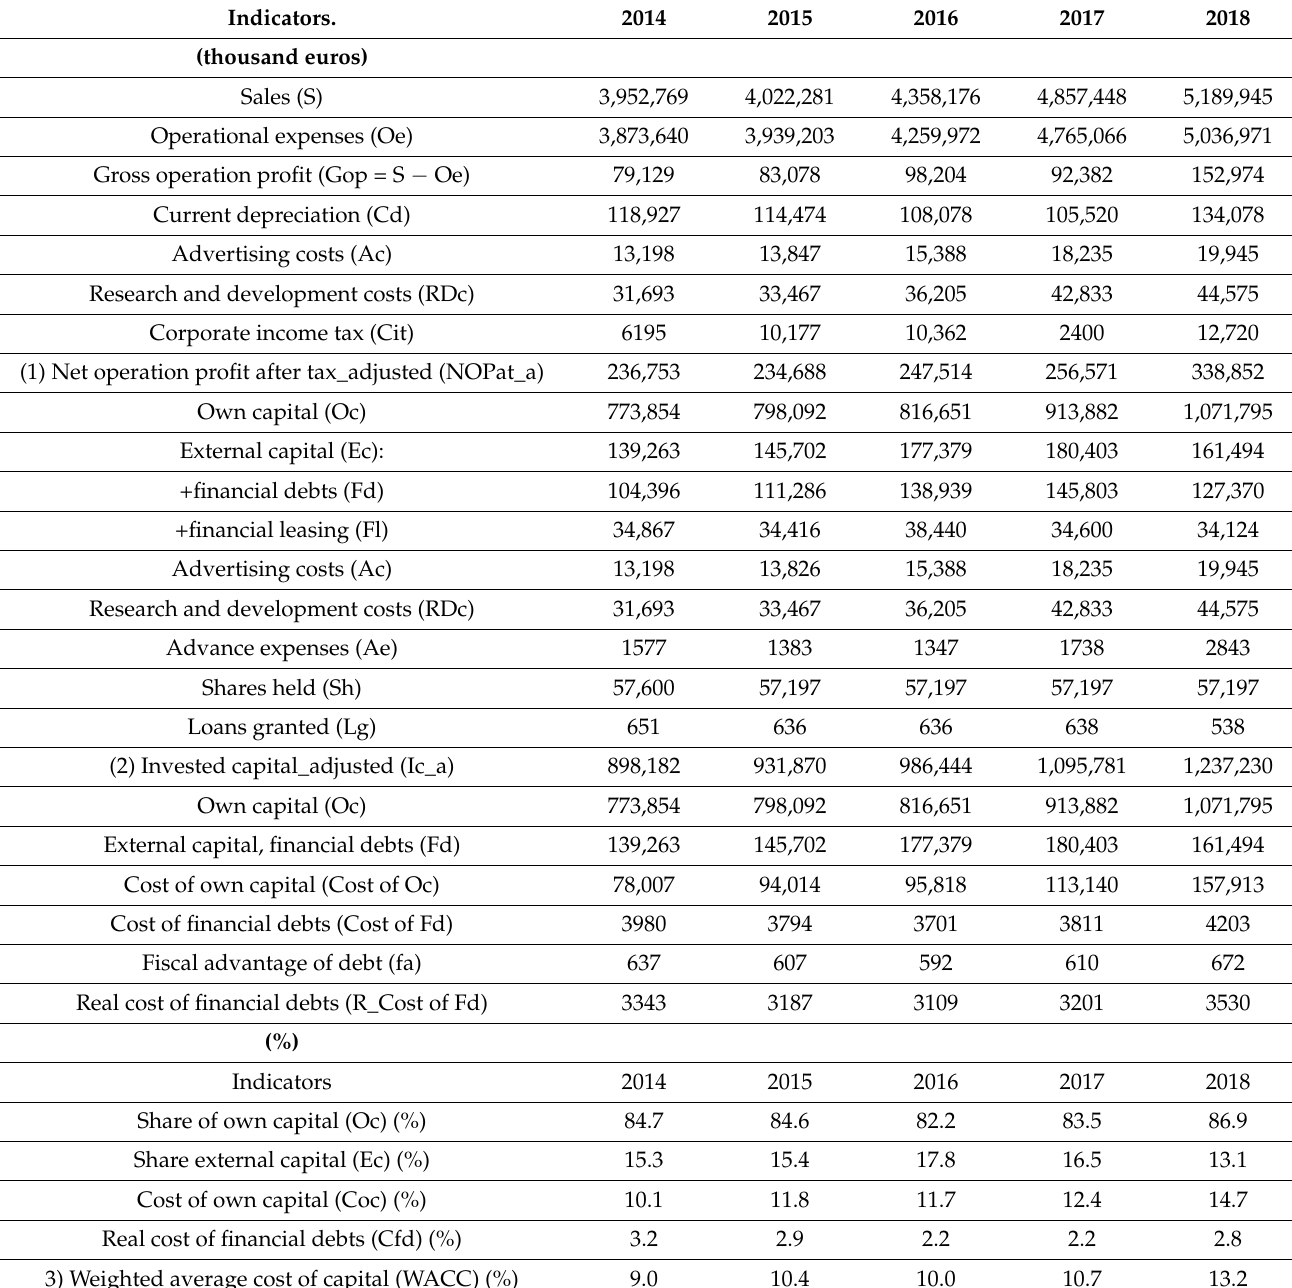
Table 2. Net operation profit after tax, invested capital, and weighted average cost of capital.